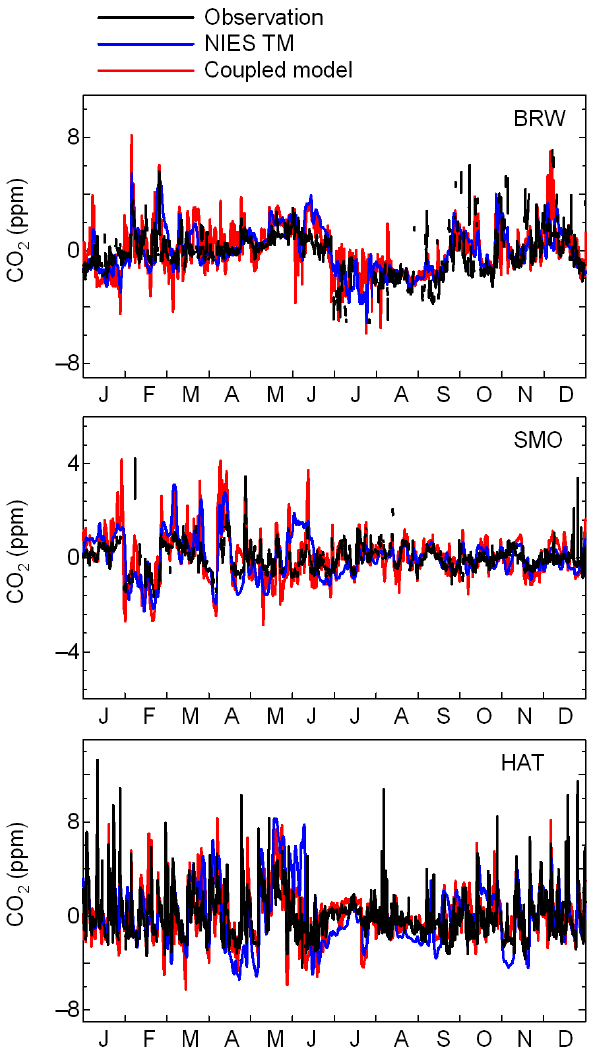
Figure 2. Deseasonalized CO 2 concentrations at Barrow (BRW, top), Samoa (SMO, middle), and Hateruma (HAT, bottom) during 2003. Black lines: observations; blue lines: NIES TM; red lines: coupled model.